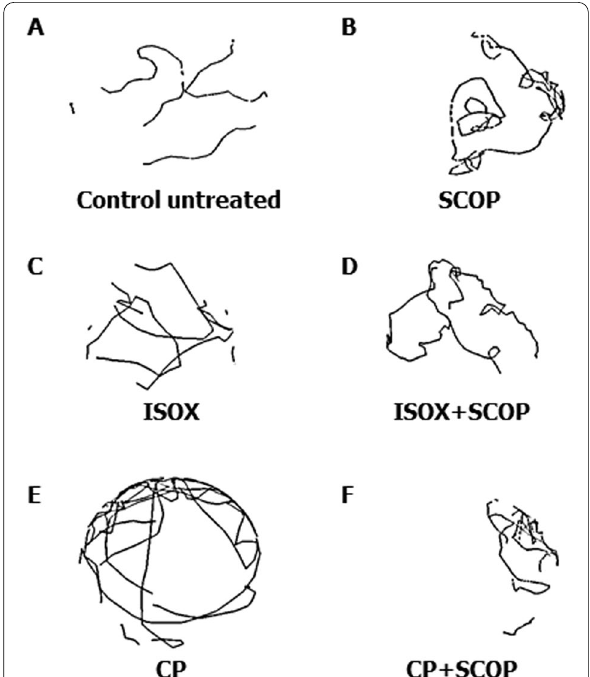
Fig. 4 Swimming patterns of larvae and adults in response to test compounds. The locomotion tracking plots (or ‘traces’) extracted from wrMTrck for A untreated, B scopolamine (SCOP)-treated, C isoxazole (ISOX)-treated, D ISOX SCOP-treated, E Convolvulus pluricaulis + (CP)-treated, and F CP SCOP-treated larvae. The 168 hpf larvae + were treated with the least toxic concentrations of SCOP (6.68 μM), ISOX (1.04 mM), and CP (0.38 mg/mL) and their combinations. Note that each larva is represented by a single trace. Three independent experiments were conducted with each of the treatment conditions to determine the locomotion patterns of the larvae. Three